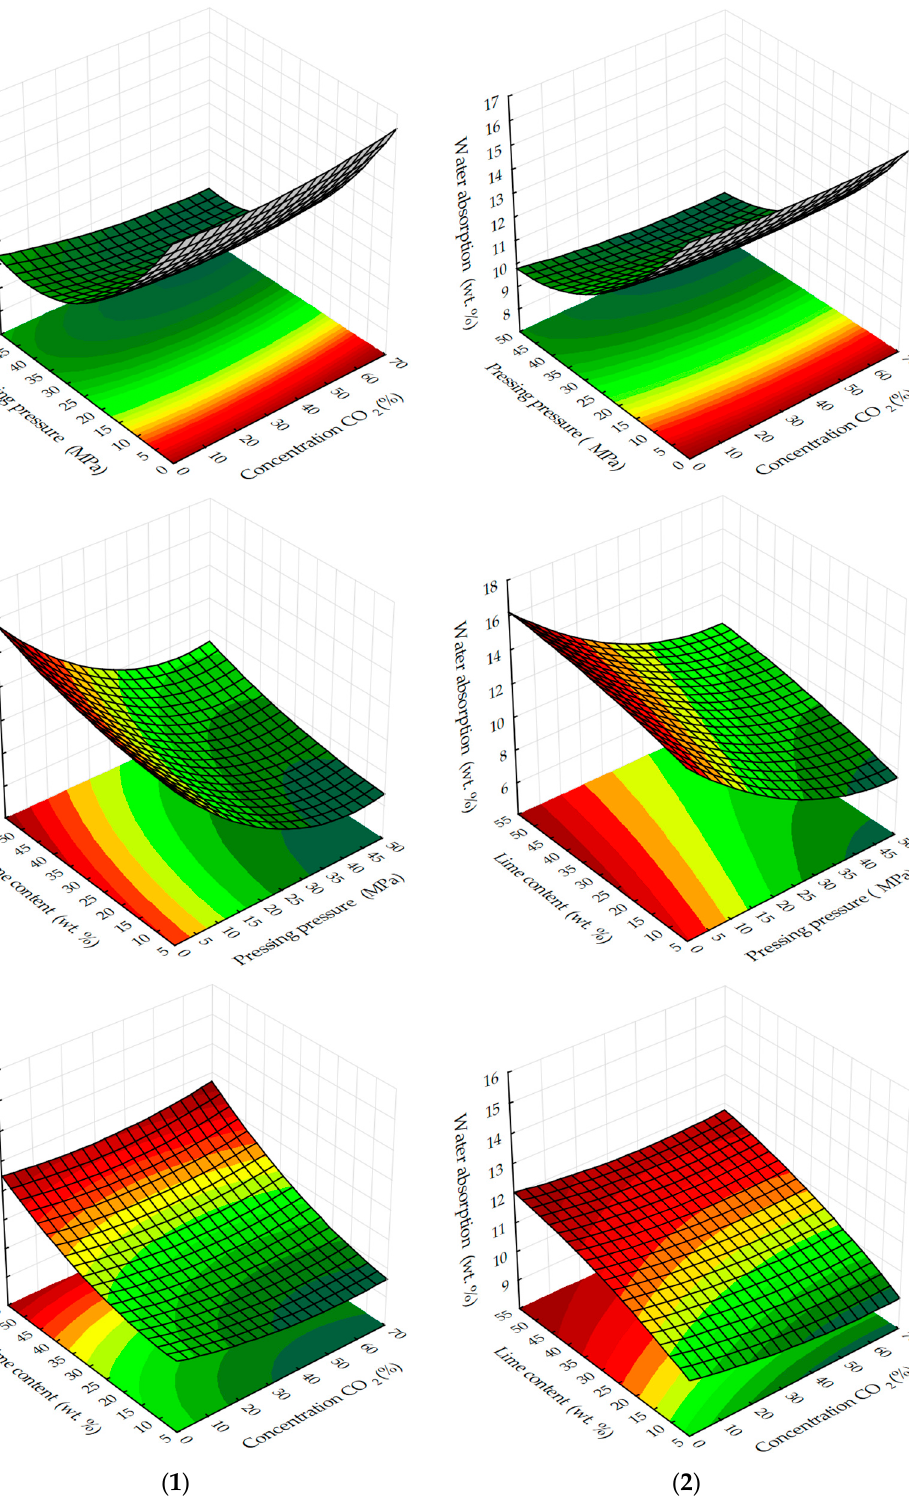
Figure 9. Response surfaces of changes in water absorption by mass of testing samples carbonated by dynamic ( 1 ) and static ( 2 ) methods, depending on: ( a ) the molding pressure and the concentration of CO 2 ; ( b ) the content of lime dust and molding pressure pressing; ( c ) the content of lime dust and the concentration of CO 2 (at zero level of variation of other factors).